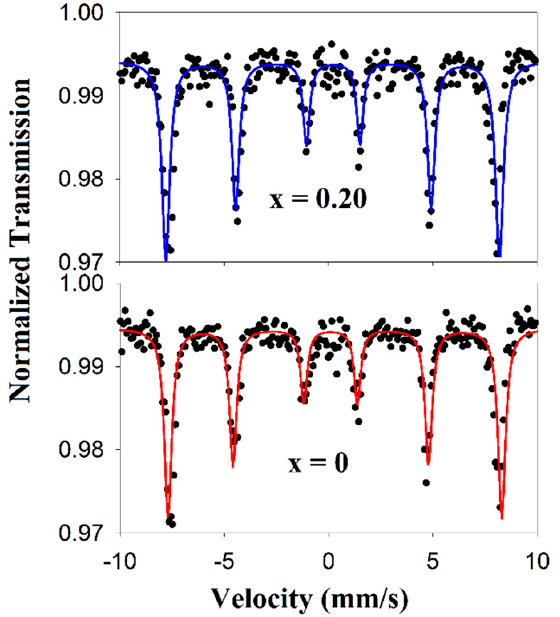
Figure 7. Room temperature 57 Fe Mössbauer spectra of powders with x = 0 and x = 0.20.